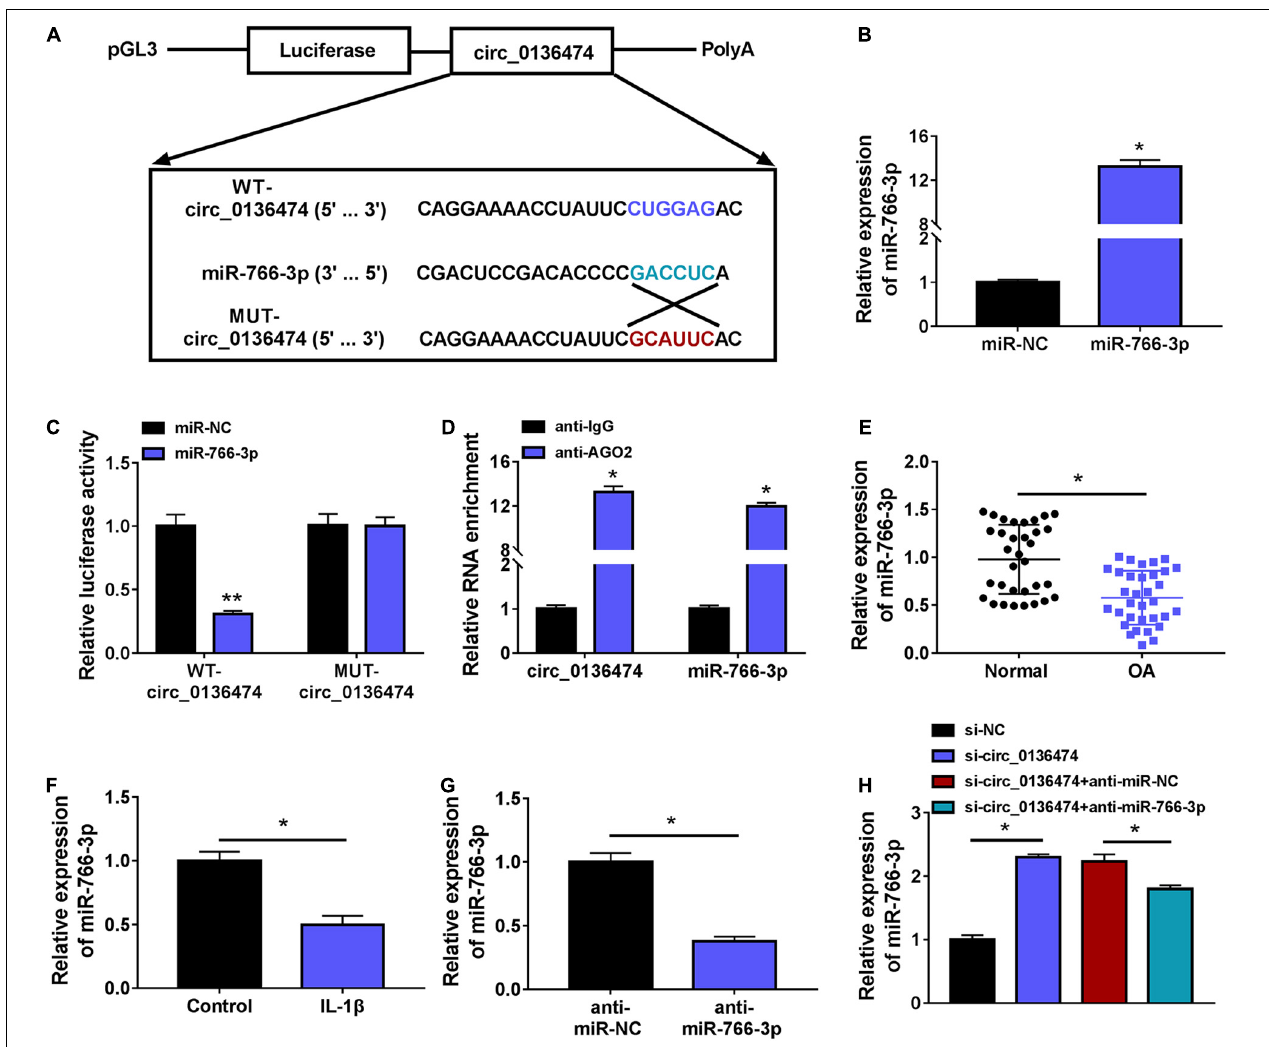
FIGURE 4 | Circ_0136474 could target miR-766-3p in human chondrocytes. (A) Schematic diagram showed the construction of pGL3 luciferase report vectors carrying WT-circ_0136474 or MUT-circ_0136474. (B) qPCR detected the relative expression of miR-766-3p in CHON-001 cells transfected with miR-766-3p/NC mimic (miR-766-3p/NC). (C) The dual-luciferase reporter assay measured the relative luciferase activity of WT-circ_0136474 and MUT-circ_0136474 vectors with co-transfection of miR-766-3p/NC. (D) The radioimmunoprecipitation assay (RIP) assay confirmed the relative RNA enrichments of circ_0136474 and miR-766-3p in CHON-001 cells. (E–H) qPCR detected the relative miR-766-3p expression in (E) OA cartilages ( n = 33) and normal cartilages ( n = 33), (F) control CHON-001 cells and IL-1 β (10 ng/m-)-induced CHON-001 cells, (G,H) IL-1 β (10 ng/ml)-induced CHON-001 cells pre-transfected with anti-miR-766-3p/NC, si-circ_0136474/NC, or si-circ_0136474 combined with anti-miR-766-3p/NC. * P < 0.05 and ** P < 0.01 were determined by unpaired t- test, ordinary one-way ANOVA, or two-way ANOVA.